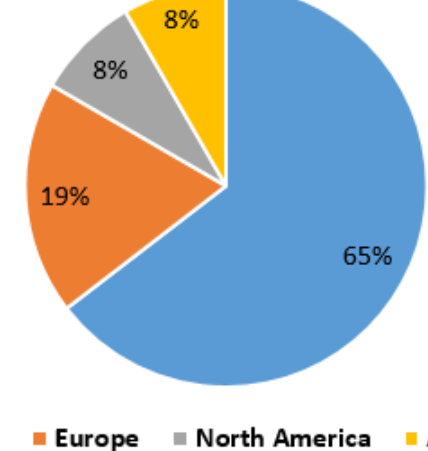
Figure 4. Articles by region.